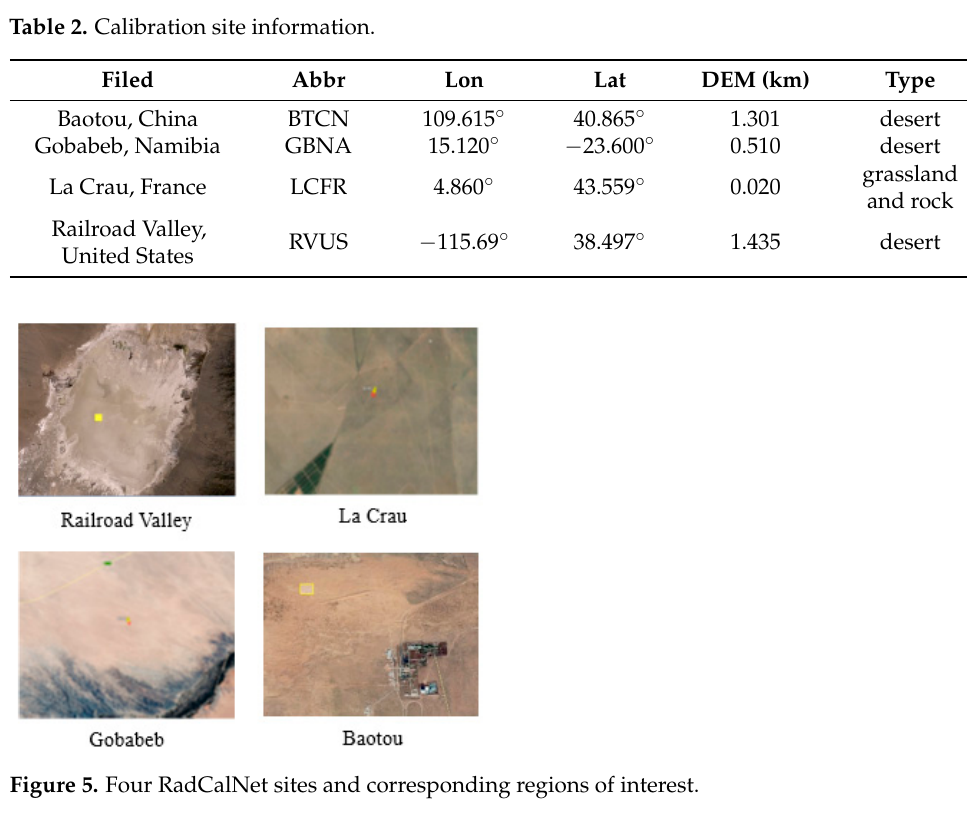
Figure 5. Four RadCalNet sites and corresponding regions of interest.